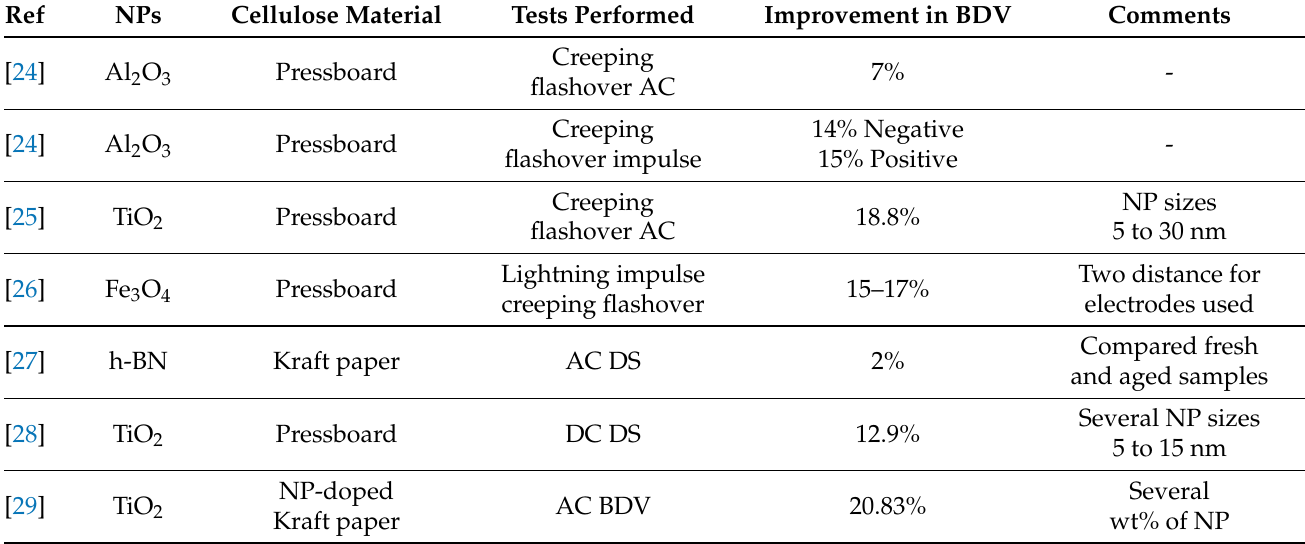
Table 1. Summary of the studies published by different authors on the characterization of the creeping flashover voltage and dielectric strength (DS) of cellulose materials with